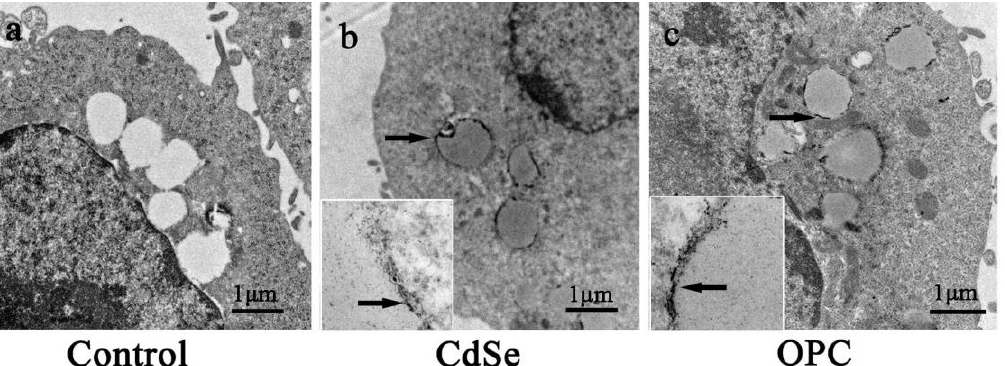
Figure 8. Representative photos of the ultrathin sections made with A549 cells after 24 h treatment. ( a ) the control group, ( b ) 20 μg/mL of CdSe nanorods, and ( c ) 20 μg/mL of CdSe nanorods and 20 μg/mL of OPC. The illustration in ( b , c ) are magnified fat droplets, the arrows in ( b , c ) are aggregated CdSe nanorods.